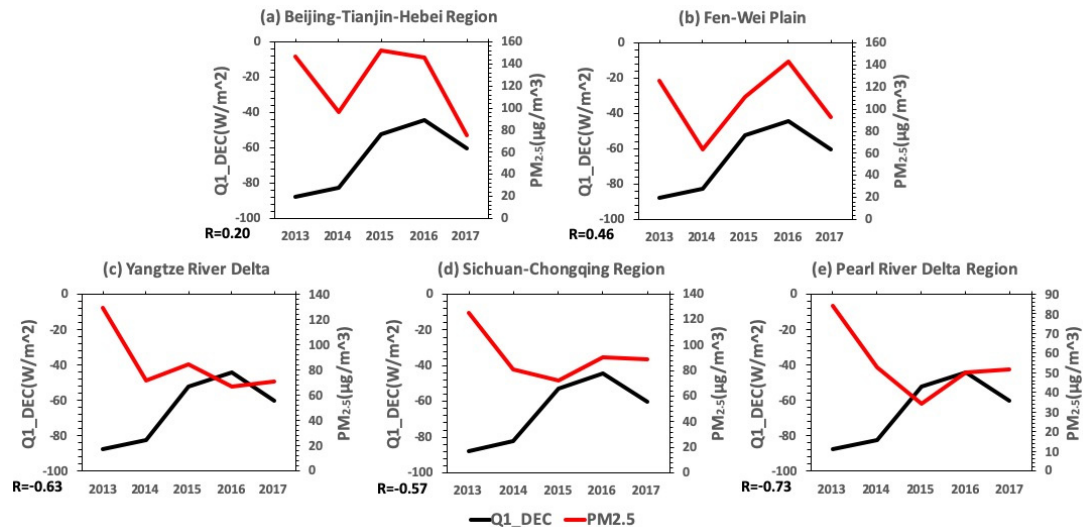
Figure 3. Correlation between the apparent heat source Q 1 on the Qinghai-Tibet plateau and PM 2.5 concentration in typical areas of China.